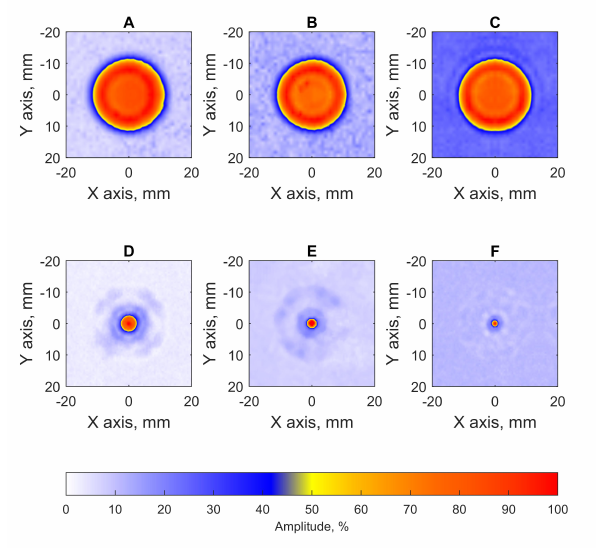
Figure 9. C-scans of samples with single flat bottom holes: ( A ) C-scan of sample A without PR-FZP application, ( B ) C-scan of sample B without PR-FZP application; ( C ) C-scan of sample C without PR-FZP application; ( D ) C-scan of sample A with PR-FZP application; ( E ) C-scan of sample B with PR-FZP application; ( F ) C-scan of sample C with PR-FZP